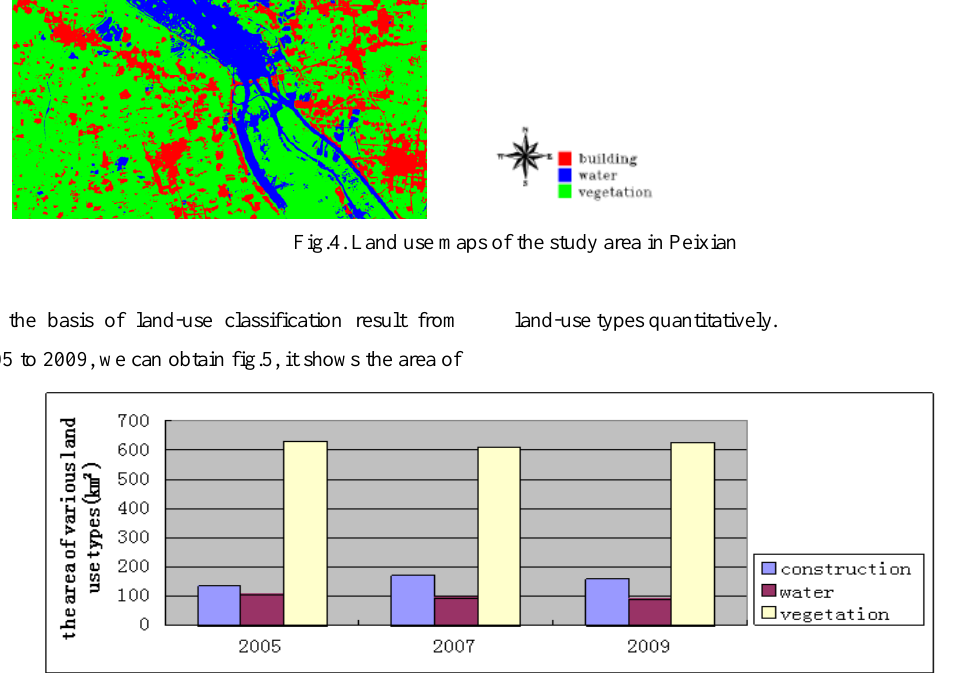
Fig.5. The area of land use types from 2005 to